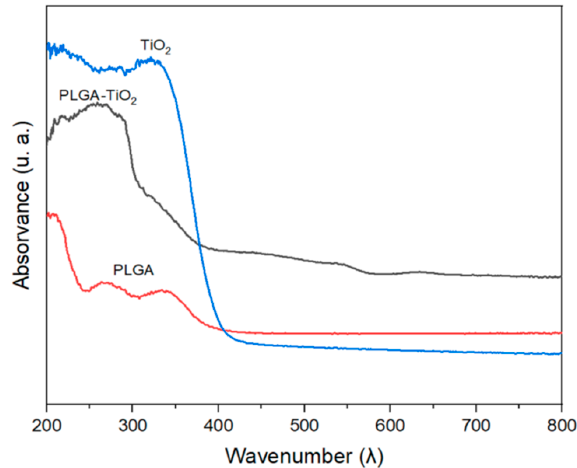
Figure 3. UV–Vis spectra of pure titanium dioxide (TiO 2 ), nanocomposite (PLGA–TiO 2 ) and poly (lactic-co-glycolic acid) (PLGA).